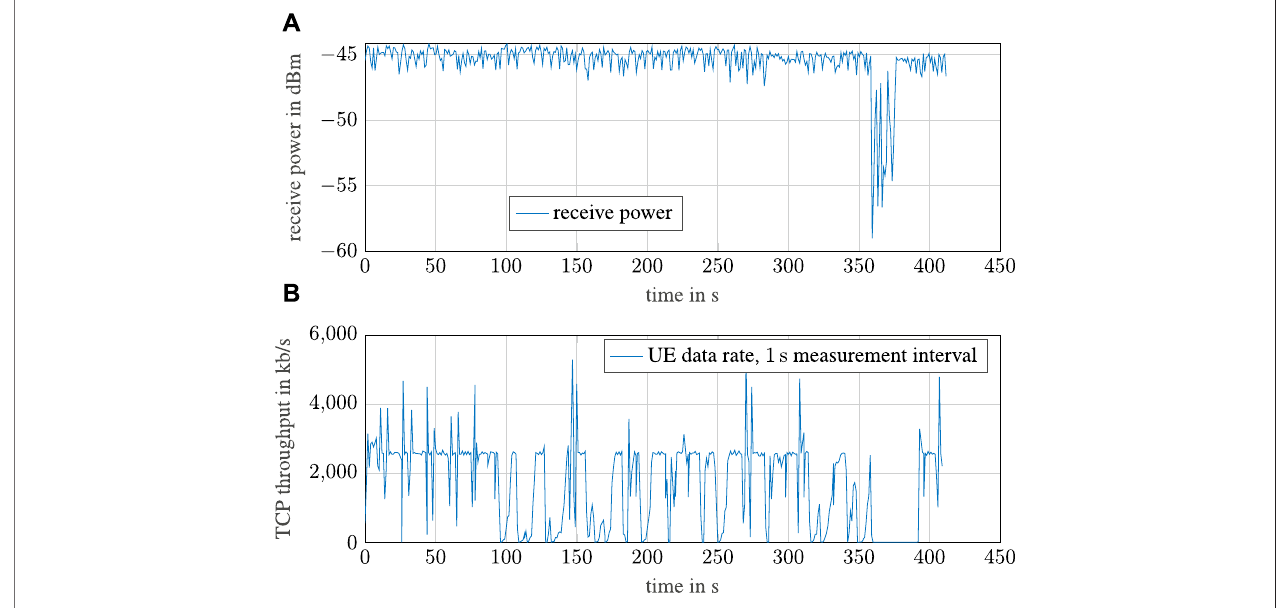
FIGURE10| Measurementresultsshowingthereceivesignalpower(satellitemodem)indBm (A) andtheTCPthroughputmeasurementsonthereturnlink(mobile scenario) (B) .